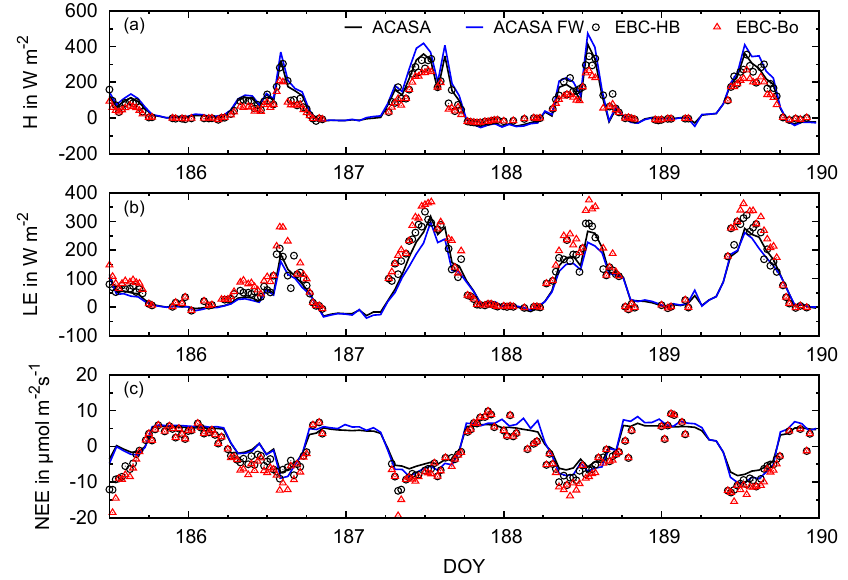
Figure 4. Same as Fig. 3 for the second